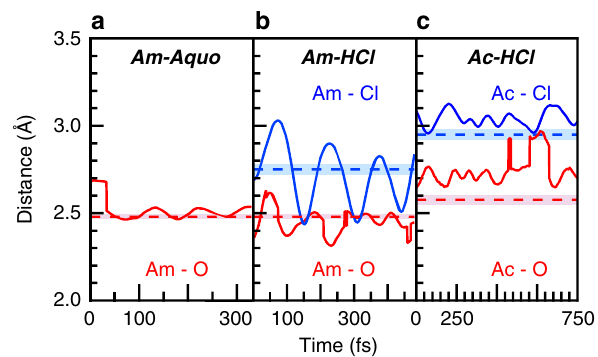
(solid red 2 O dashed red and M–Cl 2 O